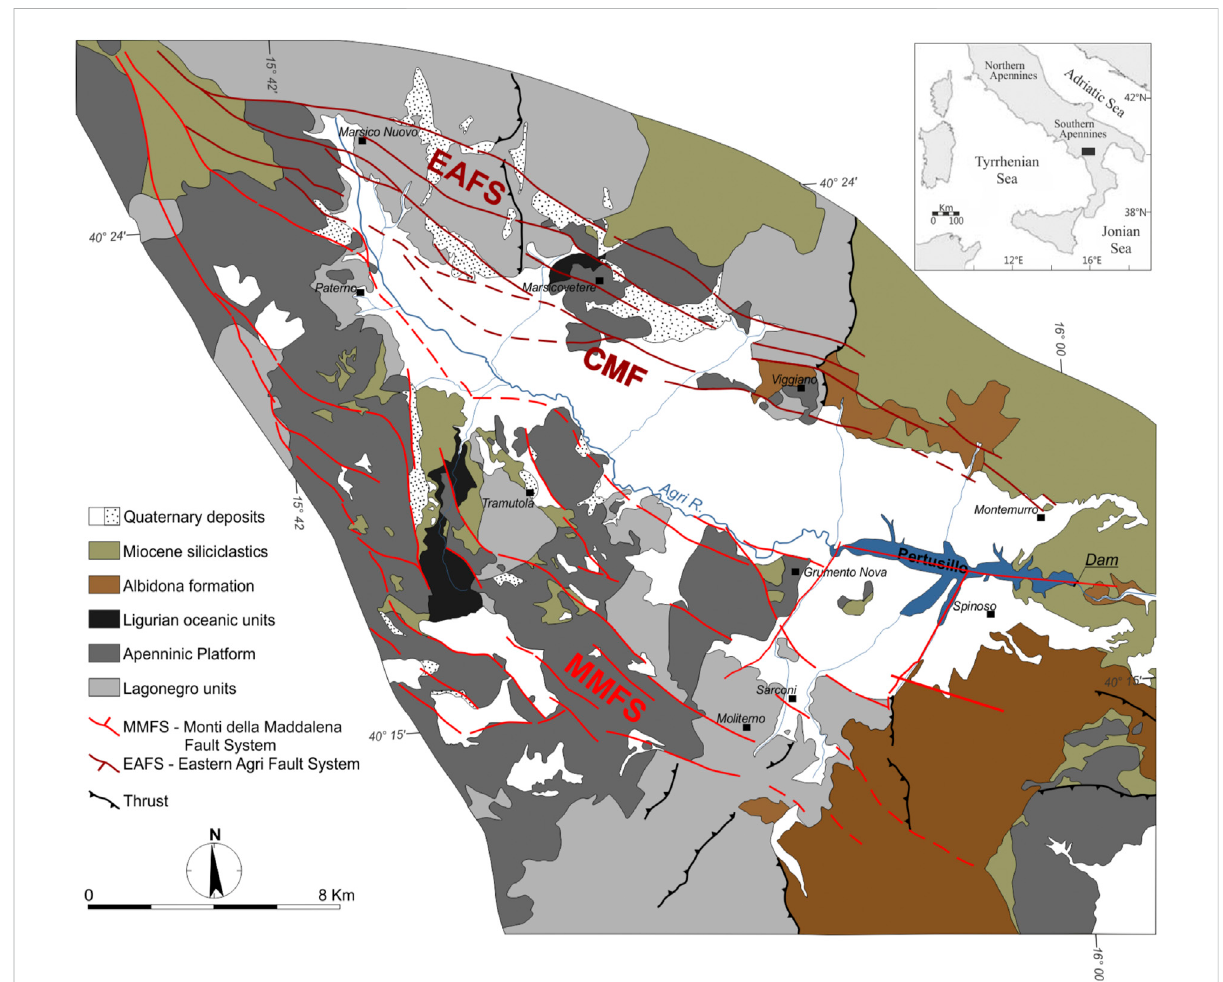
FIGURE 1 (A) Geological map of the High Agri Valley. The location of the Pertusillo reservoir with respect to the eastern Agri fault system (EAFS) to the Caggiano-MontemurroFault(CMF),andtotheMontidellaMaddalenafaultsystem(MMFS),isshowninthe fi gure[modi fi edfromGiocolietal.(2015), after Hager et al. (2021) and Bello et al.